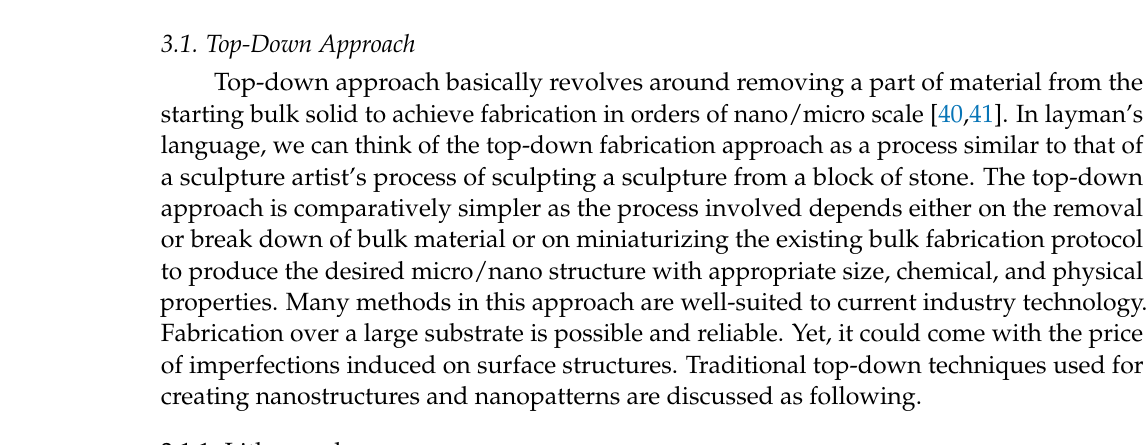
Table 2. Disadvantages of “Top-down” and “Bottom-up” techniques for nanofabrication. Top-Down Approach Bottom-Up Approach Size distribution is broad (10–100